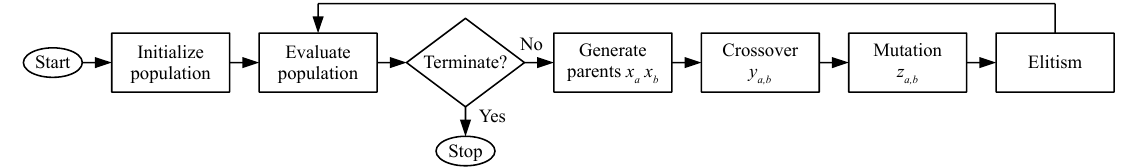
Figure 12. Flowchart of the Genetic Algorithm.